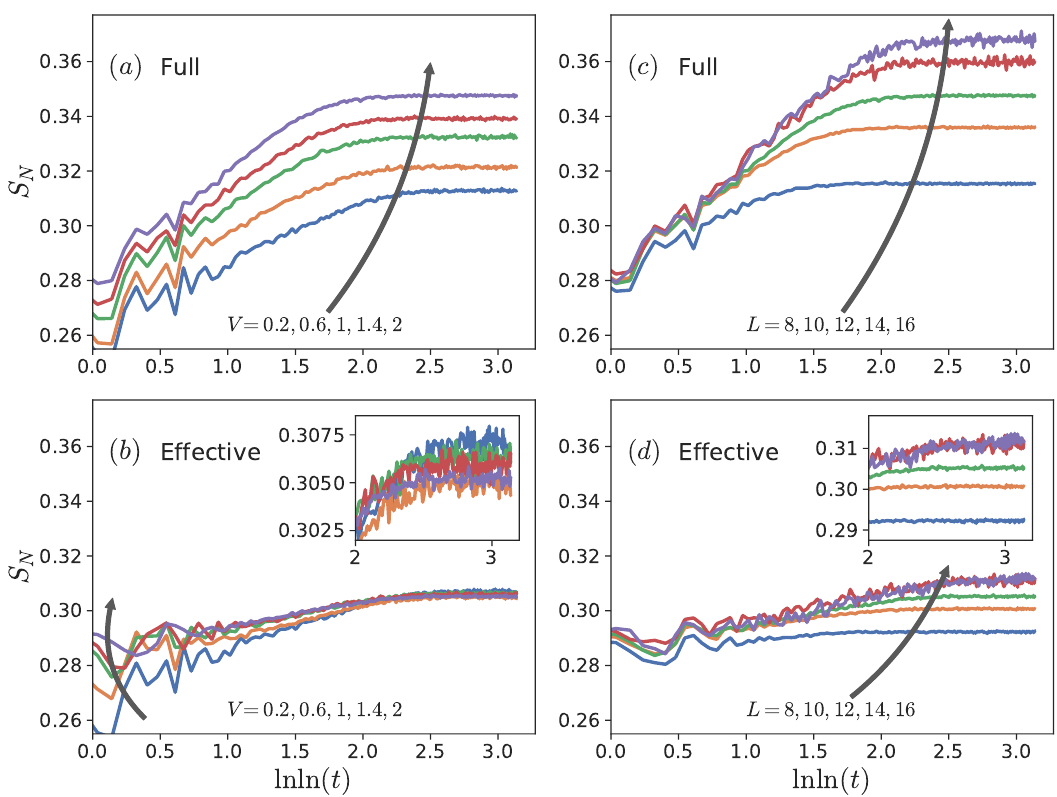
Figure 2: Number entropies for L = 8,10 (200000 samples), L = 12 (40000 sam- ples), L = 14 (4000 samples), and L = 16 (3000 samples) with D = 20: The full model is shown in the top row, the effective model in the bottom row. Left column (a, b): dependence on interaction V for L = 12, right column (c, d): dependence on length L for V = 2.0. The insets show a zoom-in into the time frame where S saturates for the effective